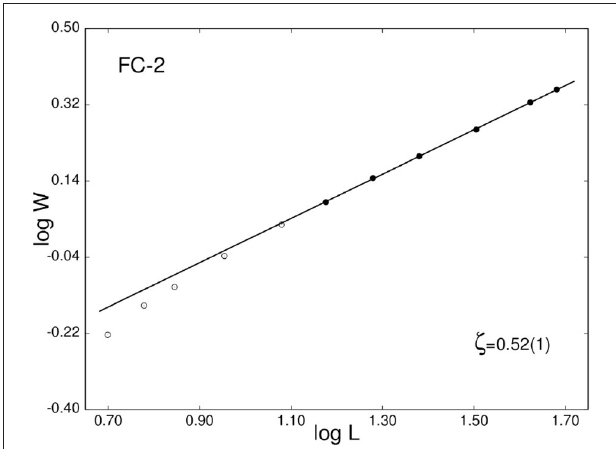
FIGURE 13 | Log-log plot showing average roughness, W , as a function of system size, L , for a large number of fractured samples of each size. Disorder magnitude is D = 4 and FC-2 denotes the result obtained with the “original” fracture criterion, Equation (22). Black dots indicate those values to which the straight line has been fit using linear regression.